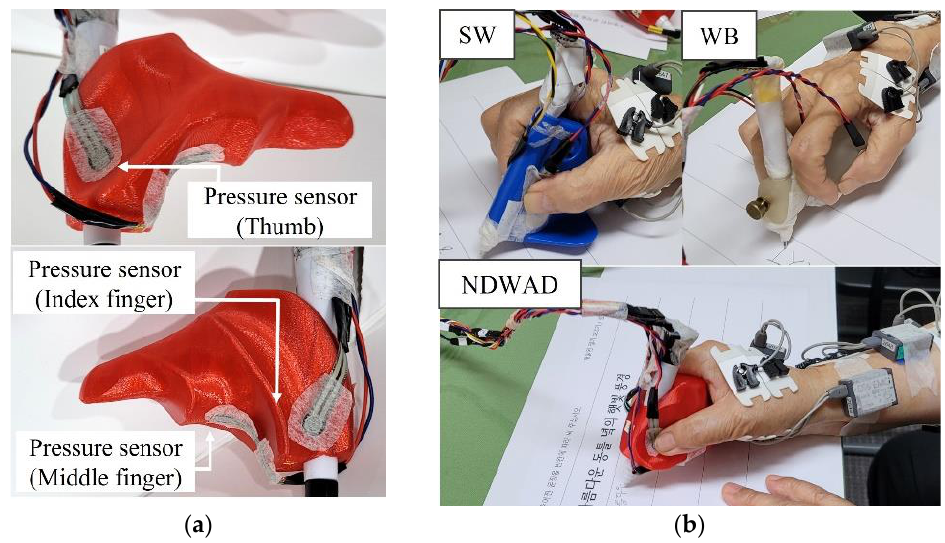
Figure 4. Pressure sensor position of the WADs: ( a ) pressure sensor and ( b ) the appearance of a pressure sensor attached to each WAD.